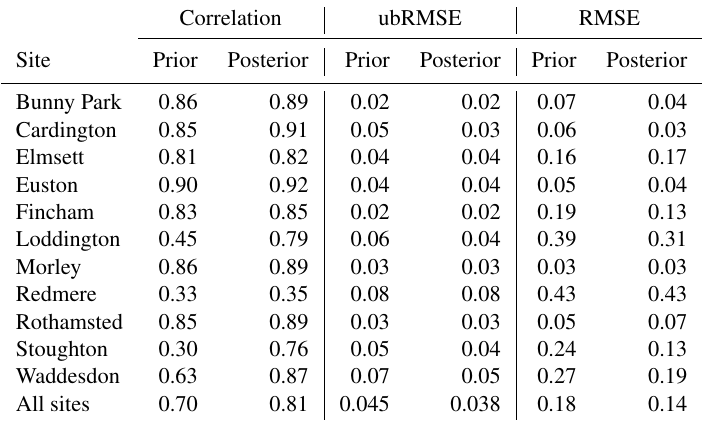
Table 3. Summary statistics for comparison of JULES-CHESS soil moisture estimates to COSMOS probe observations over the experiment period. Over all sites, we find a 16% increase in correlation, 16% reduction in ubRMSE and 22% reduction in RMSE after performing the calibration using